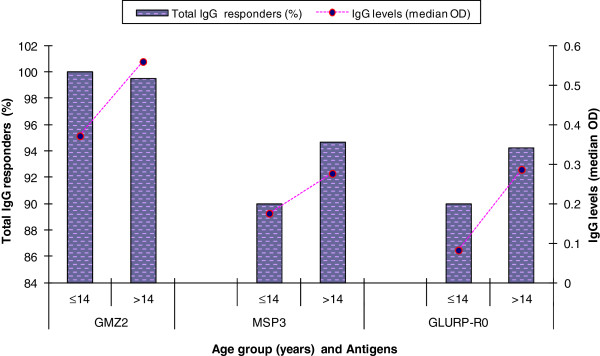
The positivity and levels of total IgG antibodies to P. falciparum, GLURP-R0, MSP3 and GMZ2 in subjects of different ages from Shewa Robit. The bars represent the proportion of total IgG responders and the broken line with filled circles represent levels (median OD) of the response.